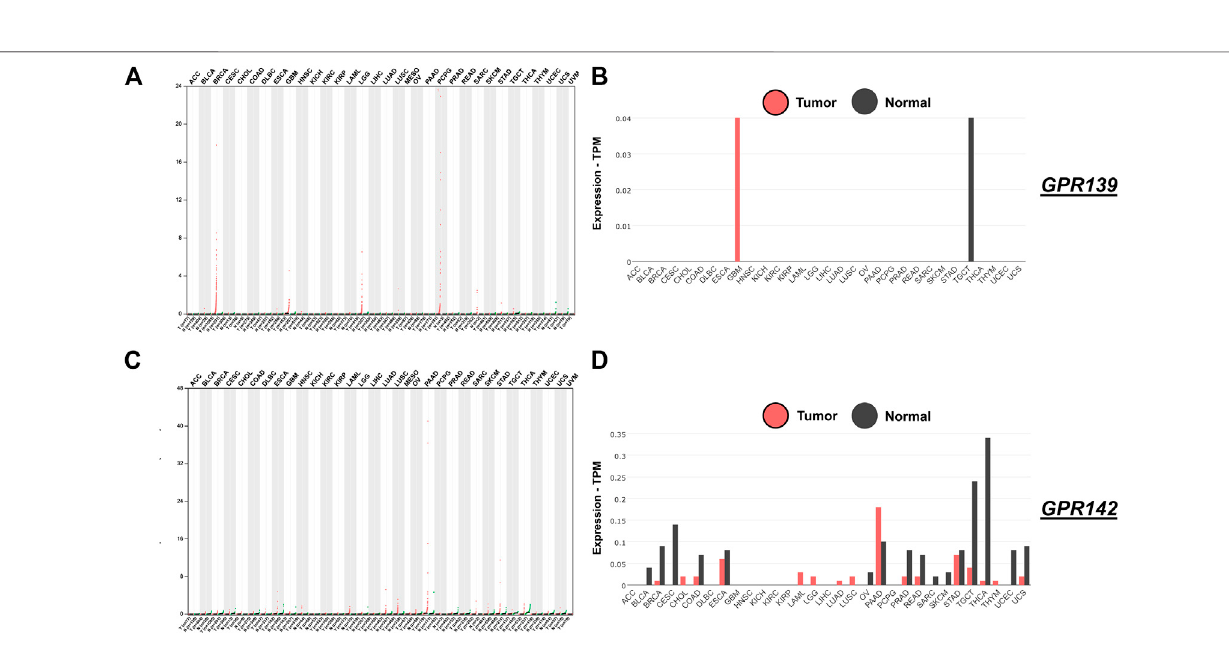
Frontiers in Pharmacology |